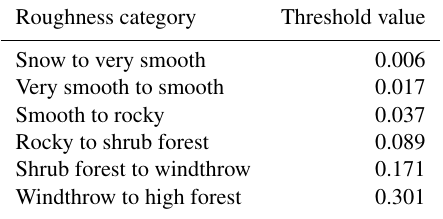
Table 3. Thresholds of roughness values between roughness cate- gories calculated using the vector ruggedness measure algorithm, with 1m resolution and a moving-window area of 49m 2